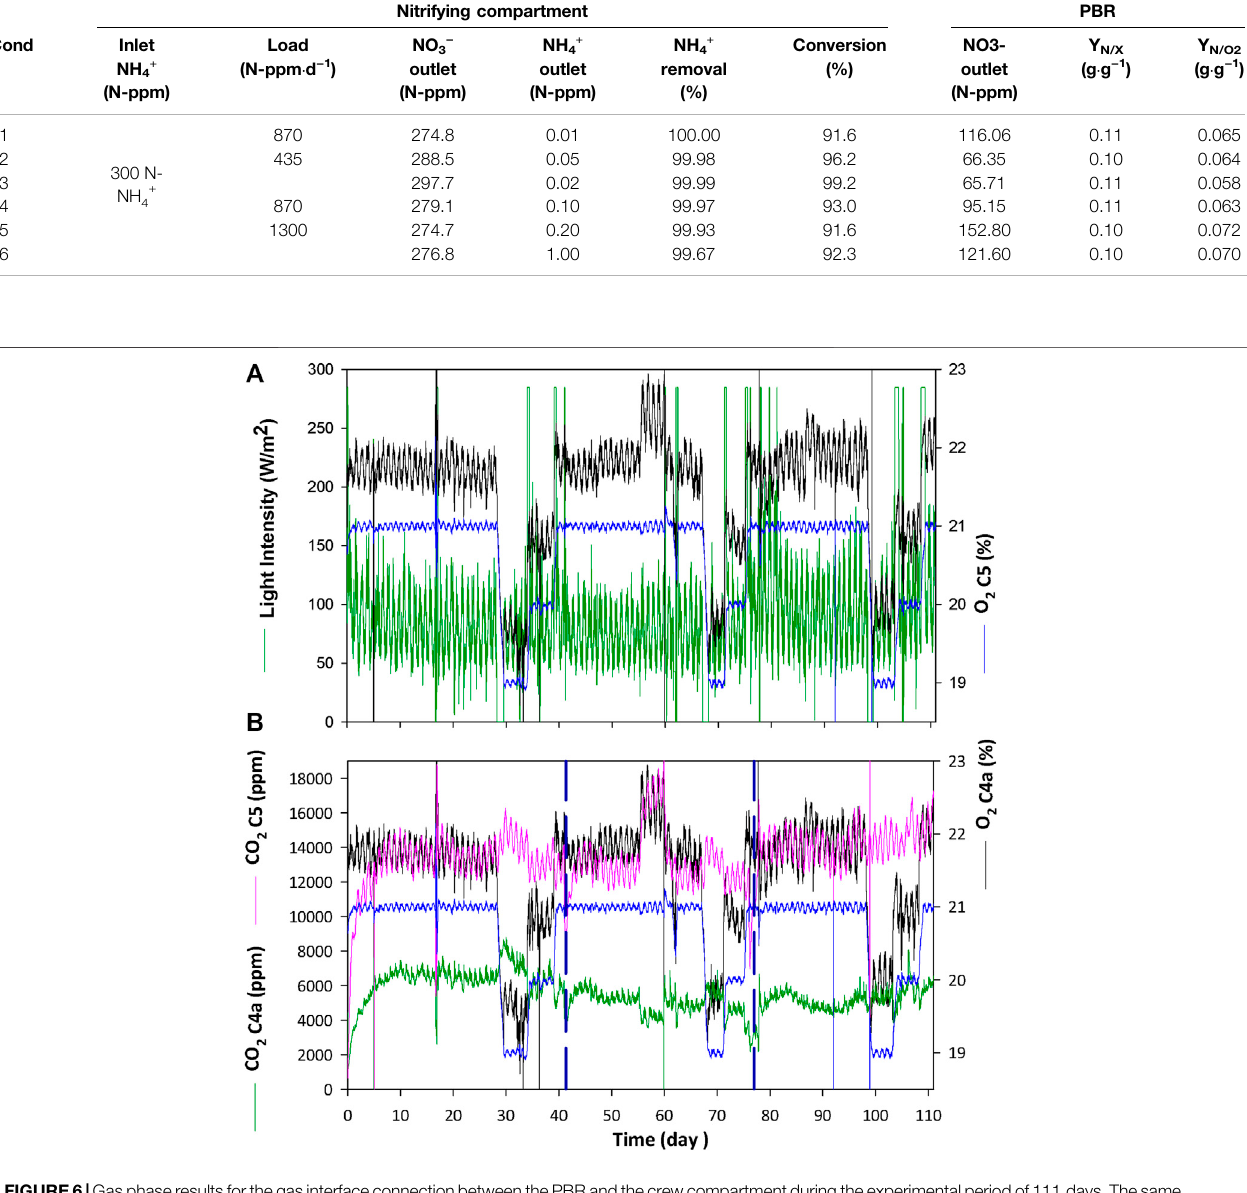
FIGURE6| GasphaseresultsforthegasinterfaceconnectionbetweenthePBRandthecrewcompartmentduringtheexperimentalperiodof111 days.Thesame oxygen set-point conditions in the crew compartment are repeated for each liquid fl ow rate tested in the PBR, which are indicated by vertical dashed lines in graph (B) . Graph (A) focusesontheoxygenpro fi lebetweencompartmentsandlightintensityinthePBR( Green: lightintensityinPBR; Blue: O 2 %inanimalisolator; Black: O 2 %at the PBR outlet). Graph (B) shows the behaviour of carbon dioxide composition ( Green: CO2 at PBR outlet; Pink: CO2 in Animal isolator; Blue: O 2 % in animal isolator; Black: O 2 % at the PBR